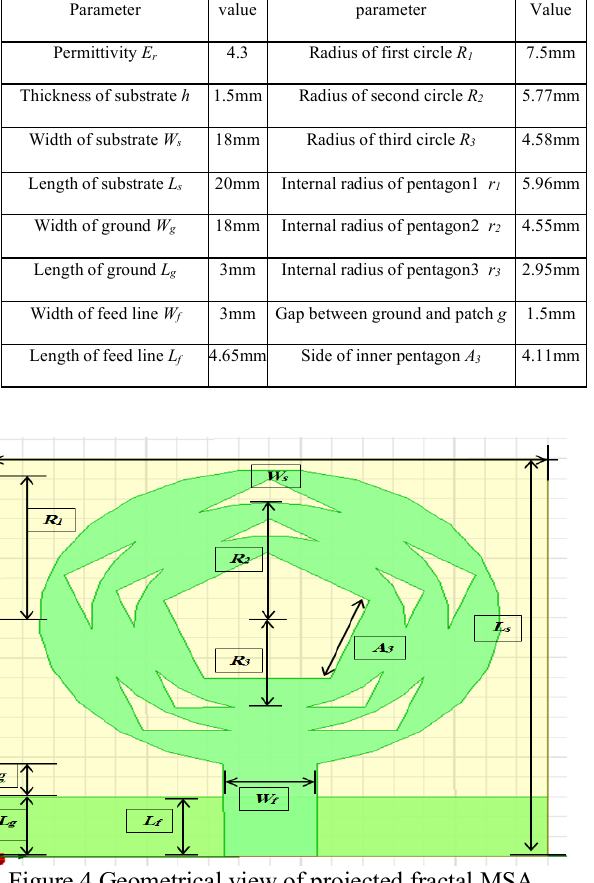
Value parameter value Parameter